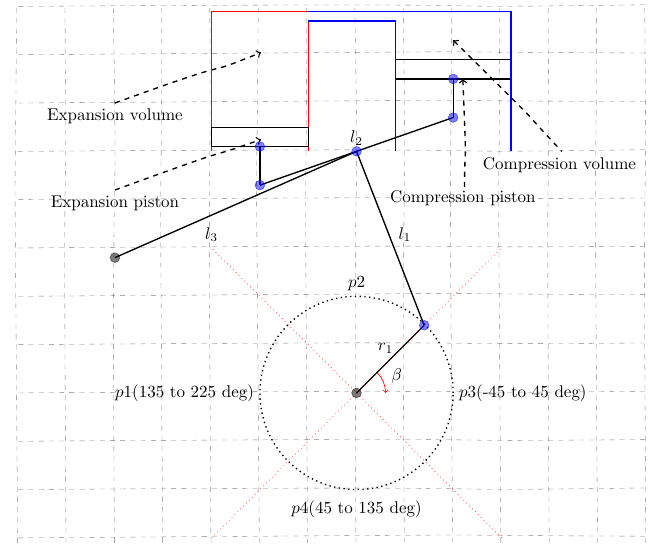
Figure 6. Alpha configuration with Ross